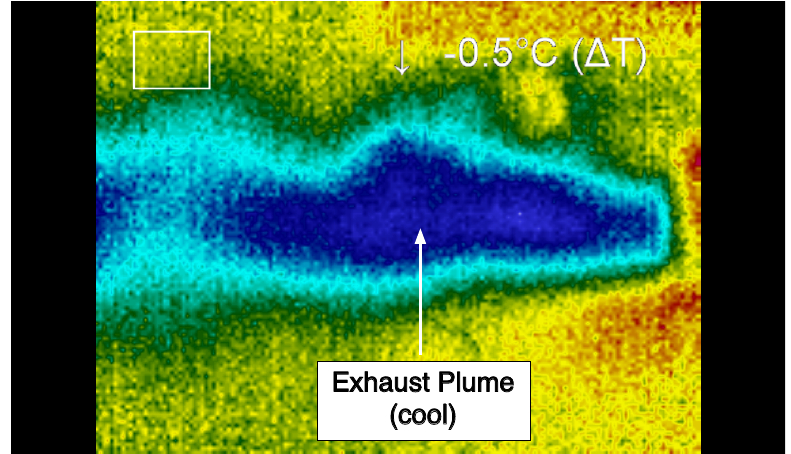
Figure 15. A stable plume created by the thruster at low gas flow rates. The blue region indicates the cooler temperature of the expanded flow within the plume.